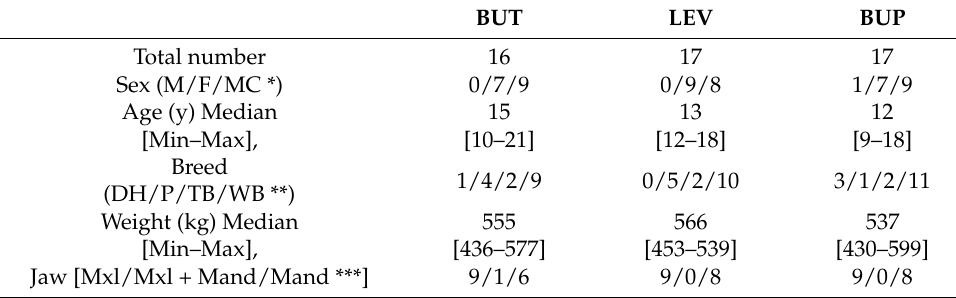
Table 2. Demographics of the patients within the groups.